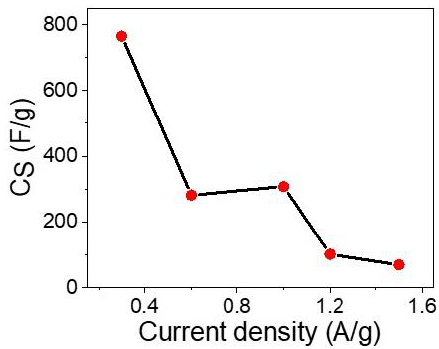
Figure 6. Rate capability of the prepared supercapacitor.